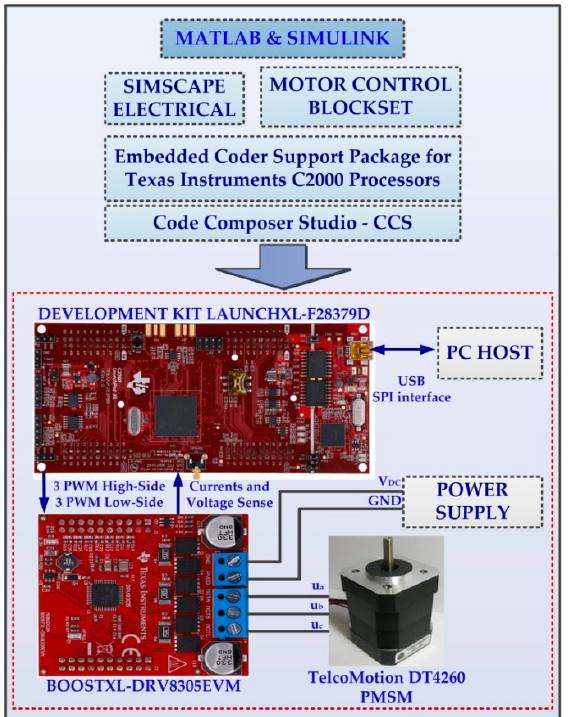
Figure 29. Development and testing architecture for the control of the PMSM application—HIL